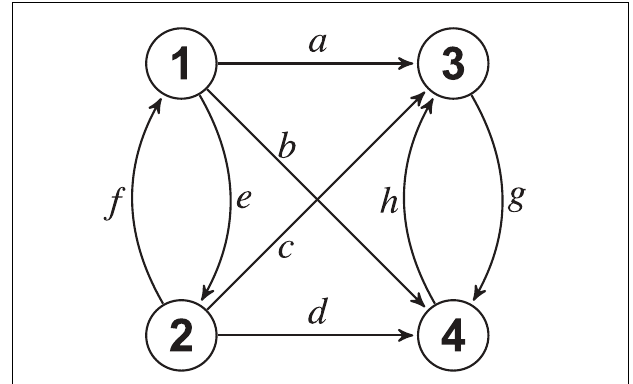
FIGURE 1 | Connectivity diagram for Example 1. The number of canonical components depends on the value of ad − bc .